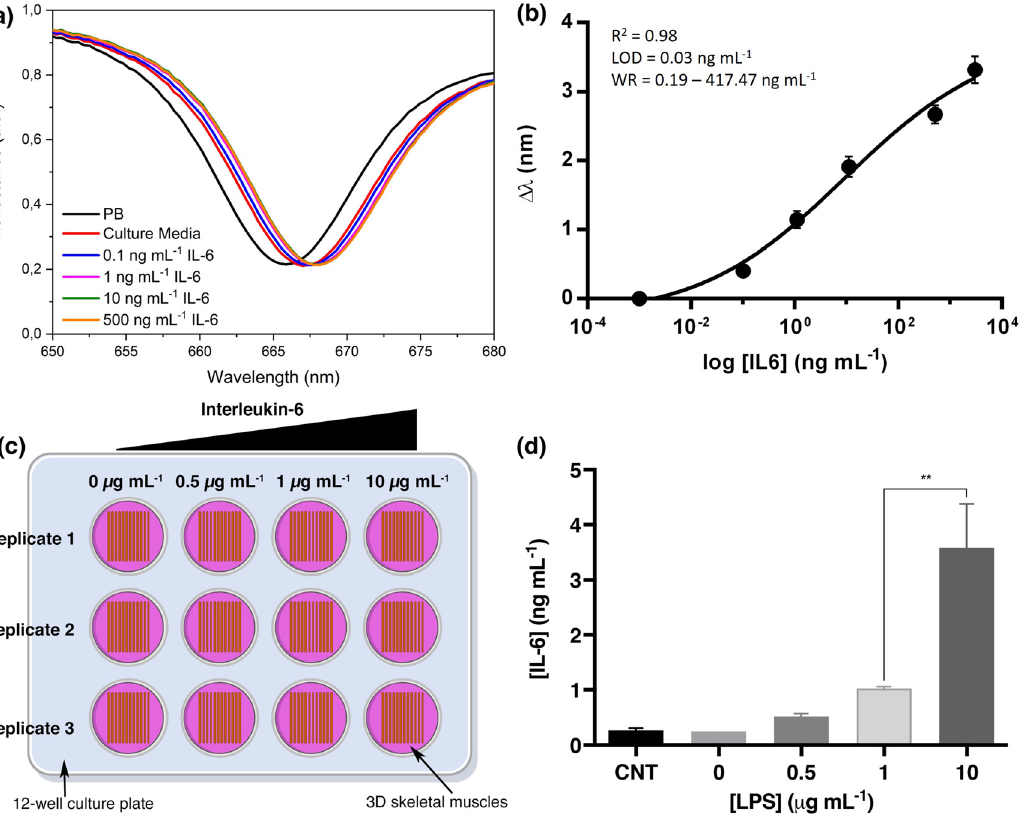
Figure 5: IL-6 biodetection in 3D skeletal muscle supernatants by 1D plasmonic nanocrystals. (a) Plasmonic band displacement with different concentrations of spiked cell culture media in an additive assay. (b) Calibration curve for the detection of the IL-6 in cell culture media supernatants ( n = 2). (c) Schematic representation of the stimulation assay of 3D skeletal muscle tissues with different concentrations of endotoxins. (d) IL-6 secretion changes with the concentration of